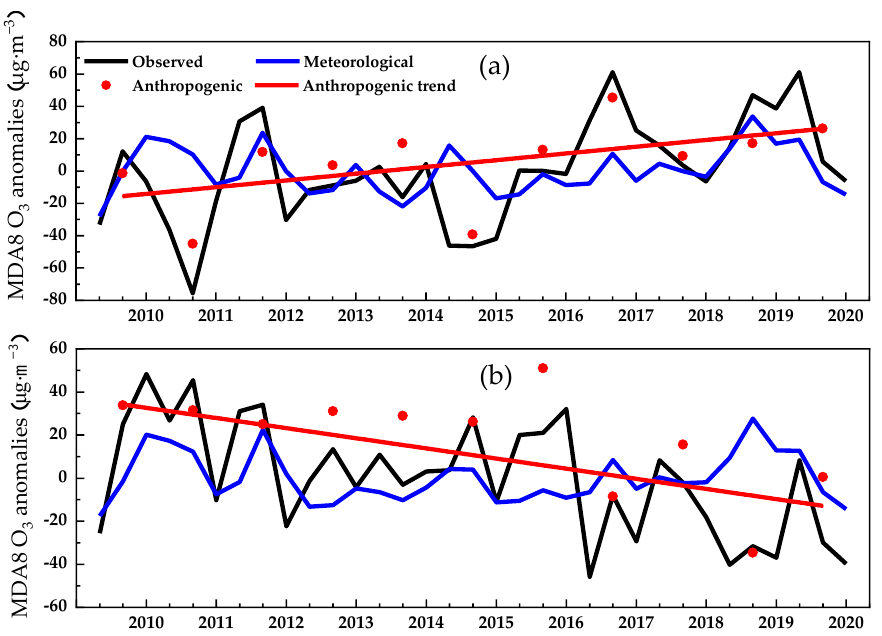
Figure 5. Time series of the anomalous values of MDA8 O 3 and MLR-simulated values (one node every ten days in June). The residuals are plotted for the June mean and describe the impact of human activities on ozone. Figure ( a ) shows the urban area (SZ), and Figure ( b ) shows the suburban area (PML). The black and blue lines represent the time series of the observed and meteorological predictions of ozone anomalies, respectively. The red dots are the mean values of the residuals between the observed and modeled values, representing the anthropogenic influence of ozone. The red line is a fitted line to the red dots, representing the trend in ozone fluctuations due to the anthropogenic influence.